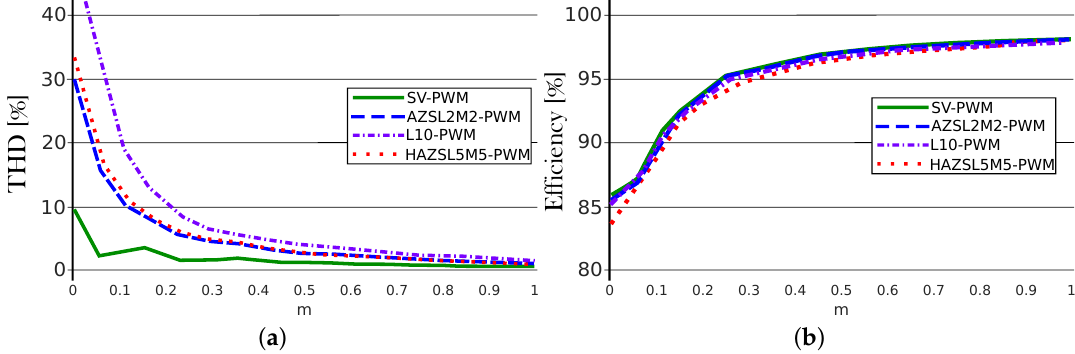
Figure 9. Total harmonic distortion (THD) and efficiency of studied modulation techniques for static operation points. ( a ) THD. ( b )